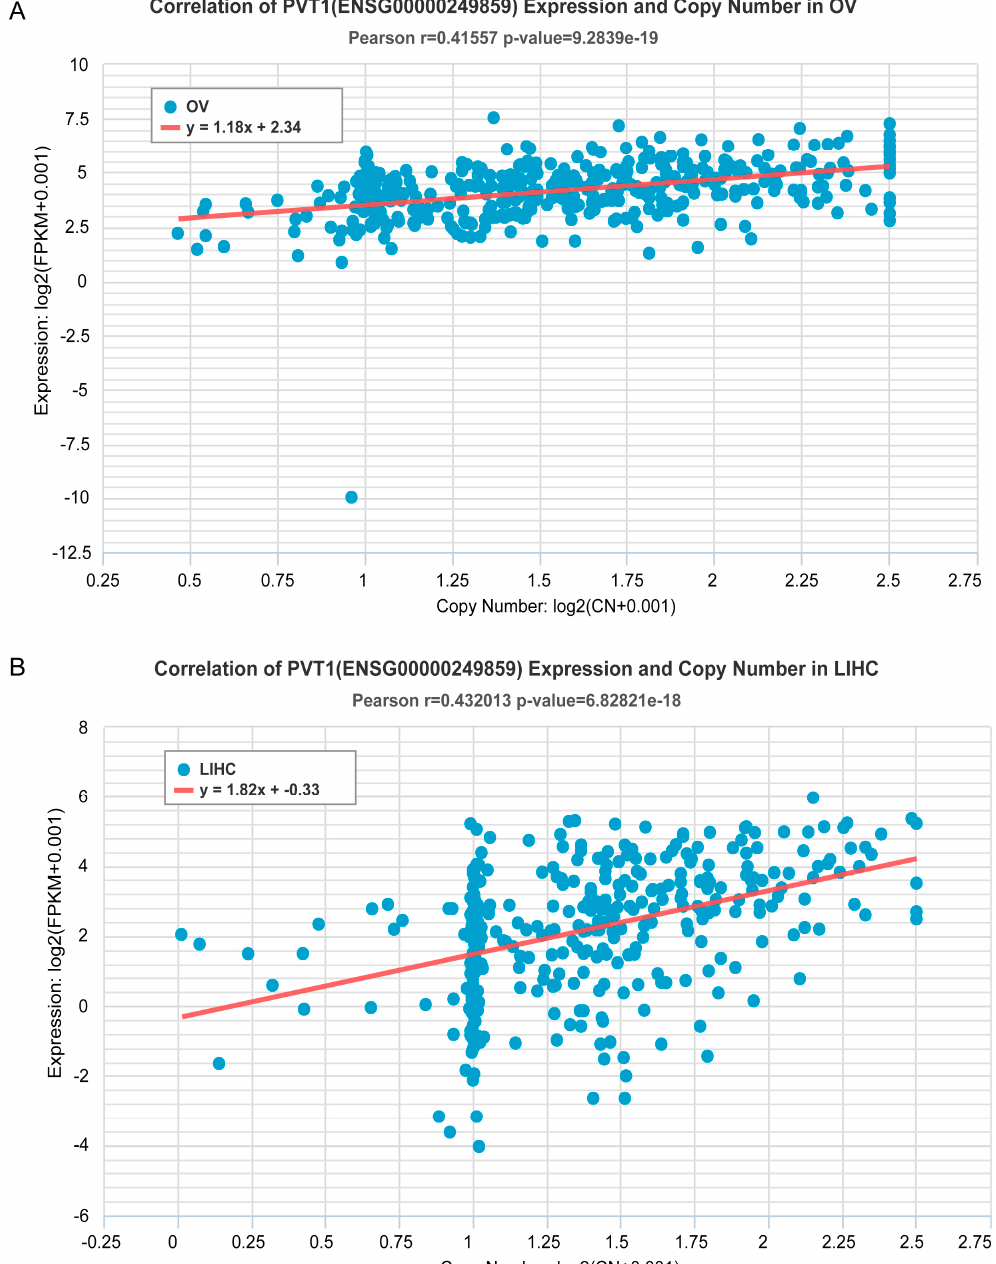
Figure 3. lncRNA PVT1 with significant amplification and overexpression. ( A ) PVT1 shows the significant and positive correlations between expressions and SCNAs in Ovarian Cancer (OV); ( B ) PVT1 shows the significant and positive correlations between expressions and SCNAs in Liver Hepatocellular Carcinoma (LIHC.)